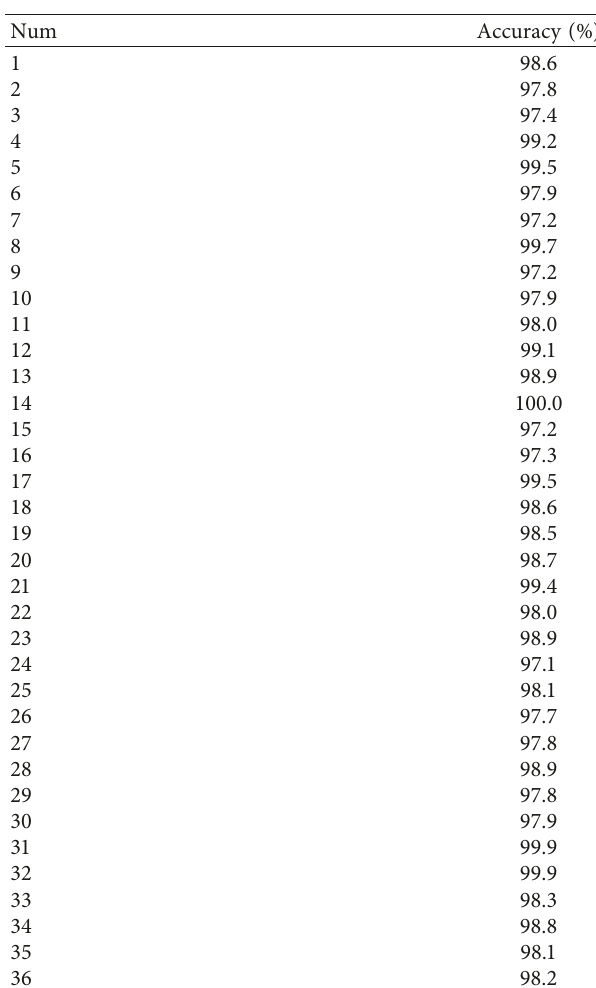
Figure 10: Robot system scheme composition. Table 1: Statistical table of the accuracy of bolt positioning based on multivision industrial robots.